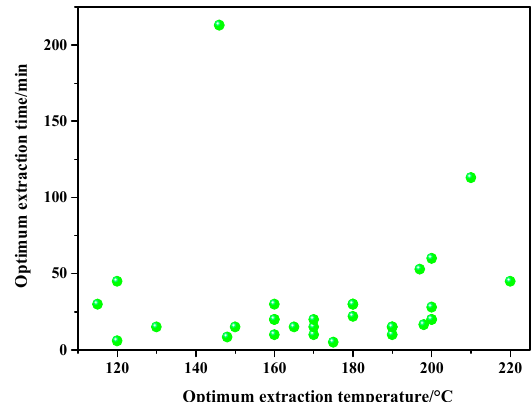
Figure 6. Optimum extraction conditions